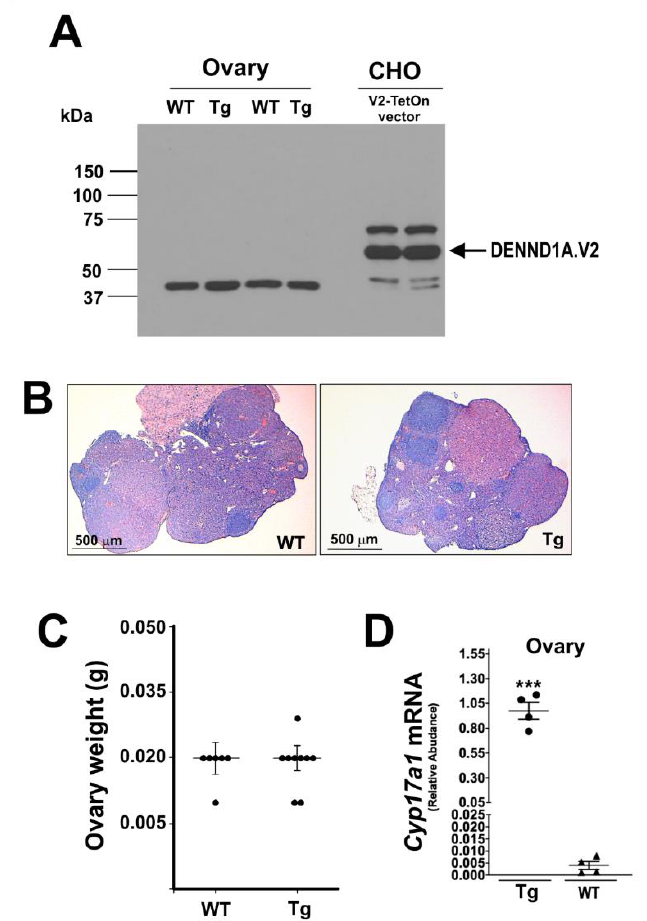
Figure 10. The TetOn-hDENND1A.V2 transgenic mouse profile. ( A ) Immunodetection on a Western blot for hDENND1A.V2 protein in transgenic mice. ( B ) Representative histological images from ovaries collected from wild-type and TetOn-hDENND1A.V2 transgenic mice. A total of 100 μg protein were loaded into the wells containing samples from mouse ovaries, and 10 μg for CHO cells. ( C ) Measurements of the ovary weight from wild-type and transgenic mice. No significant differences were found ( p > 0.05). ( D ) Ovarian Cyp17a1 mRNA levels were elevated in TetOn-hDENND1A.V2 transgenic mice compared to the WT (***, p = 0.0001). WT, wild-type; Tg, transgenic; V2.TetOn, pRP[Tet-on]-TRE-hDENND1A.V2